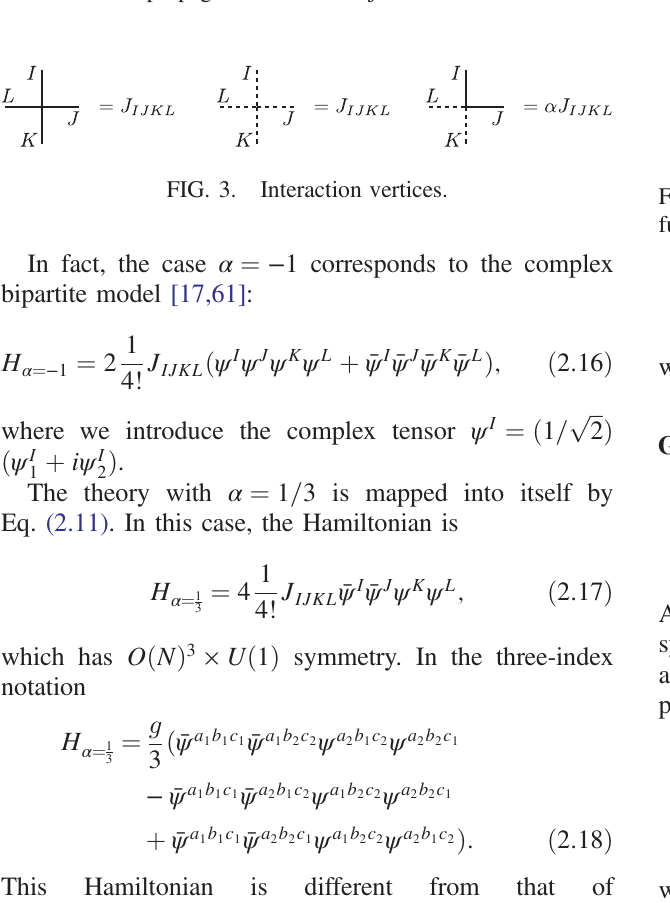
FIG. 2. Bare propagators for the Majorana tensor fields. Each thick black solid or dashed line carries three tensor indices a , b , c .